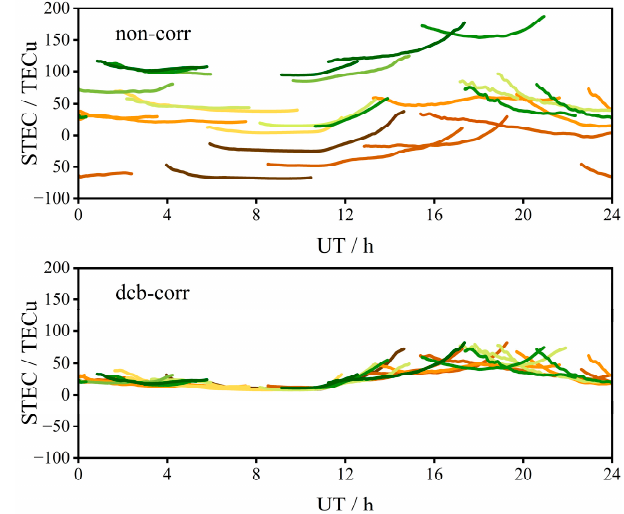
Figure 14. STEC of UC123-0 model at AREG.